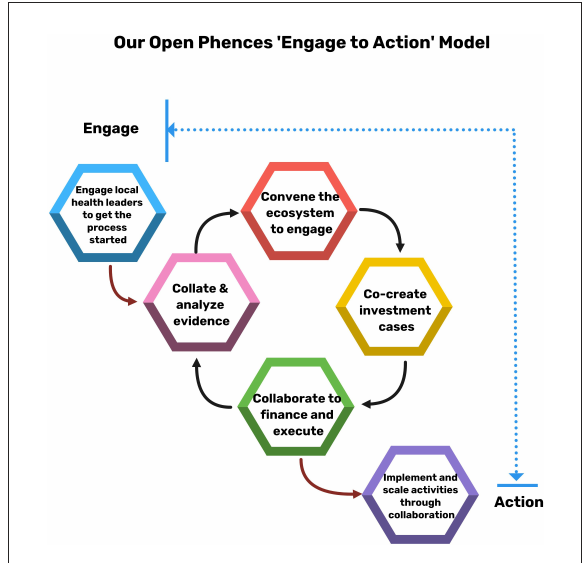
FIGURE1 The Open Phences “Engage to Action”